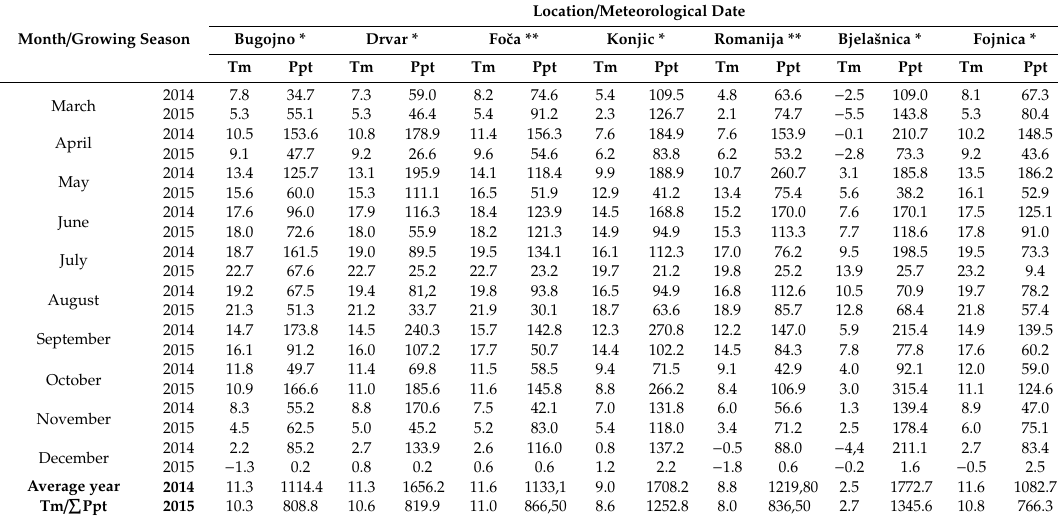
Table 2. Sample codes of wild fruit species. Genotype Growing Region Sample Code